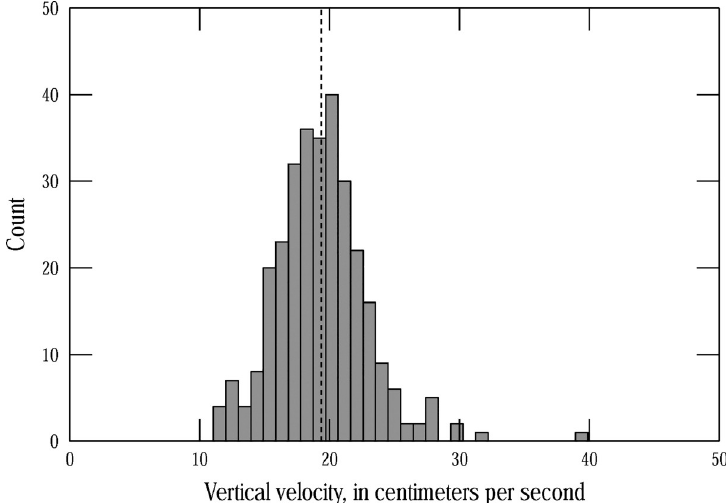
Fig 6. Histogram of calculated vertical air bubble velocities. The vertical dashed line shows the mean vertical velocity of 19.4 cm/s.